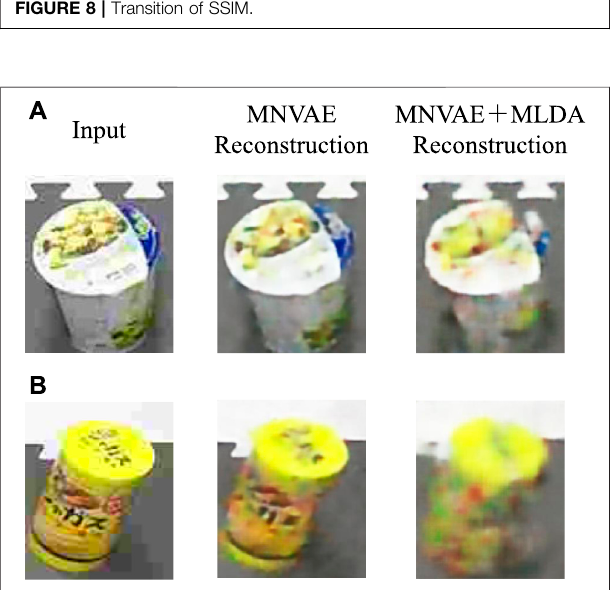
FIGURE 9 | Examples of reconstructed images: (A) cup noodle and (B) candybox. Left:inputimage, center:reconstructedimageusingonly MNVAE, and right: reconstructed image using MNVAE +